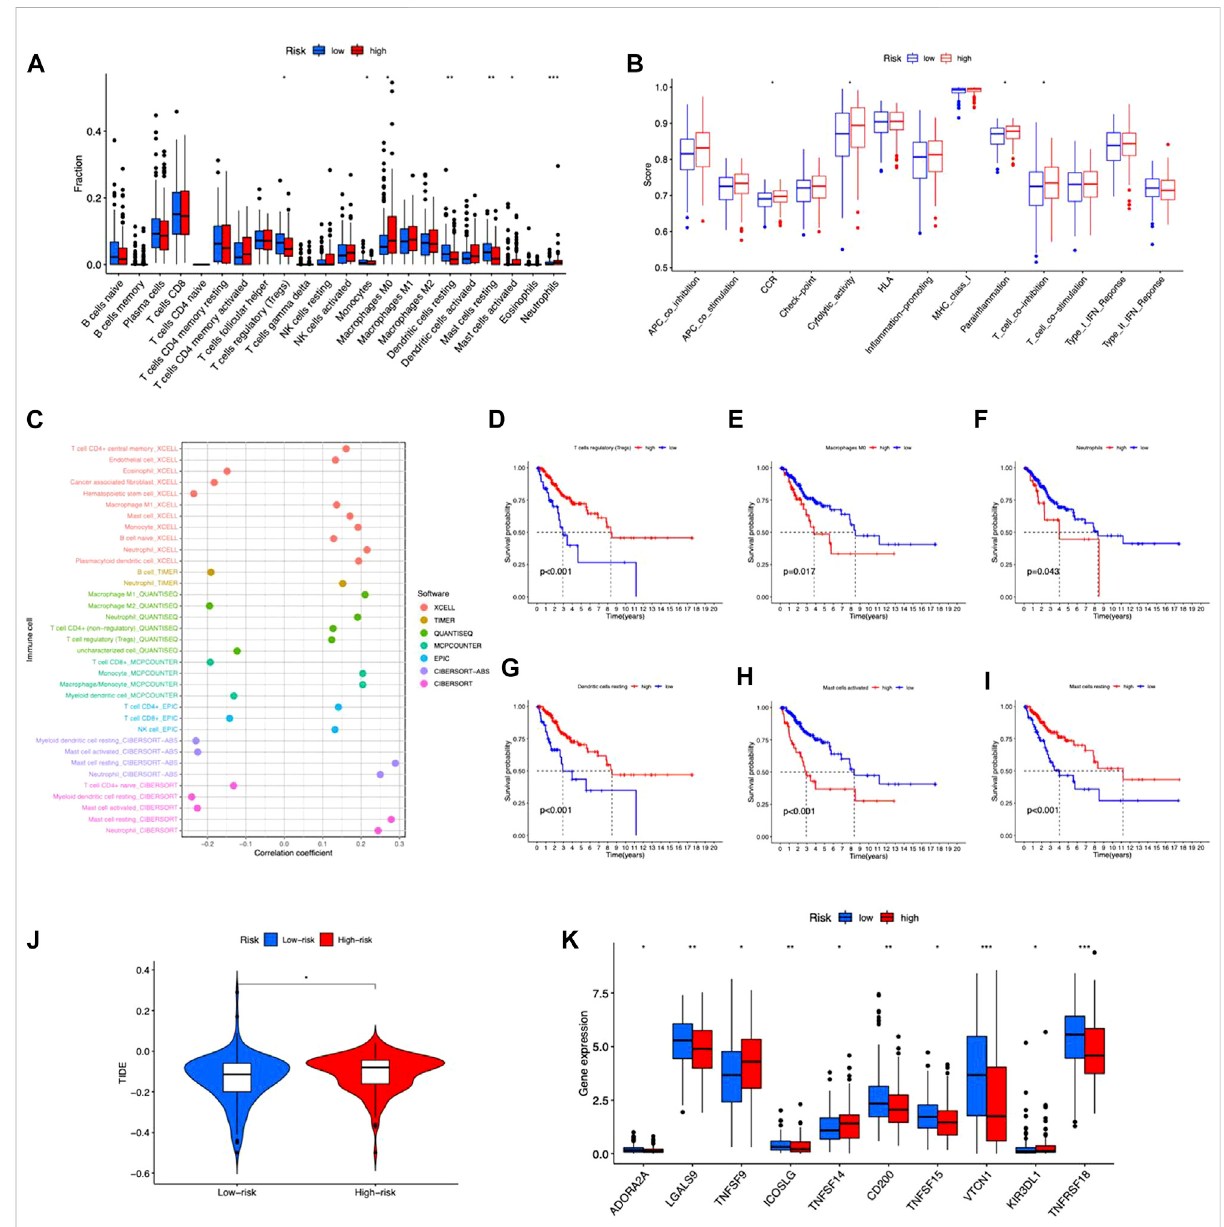
FIGURE 7 Tumor immune microenvironment in the risk model. (A) Different tumor-in fi ltrating lymph cells in patients with CC of high- and low-risk groups. (B) Immune functions of high- and low-risk groups. (C) Correlation between in fi ltrating immune cells and risk scores. (D – I) Kaplan – Meier survival curves for high- and low-level of different immunocytes. (J) TIDE scores between the two groups. (K) Differences in expression of immune checkpoints in the risk groups. *p < 0.05, **p < 0.01, ***p <